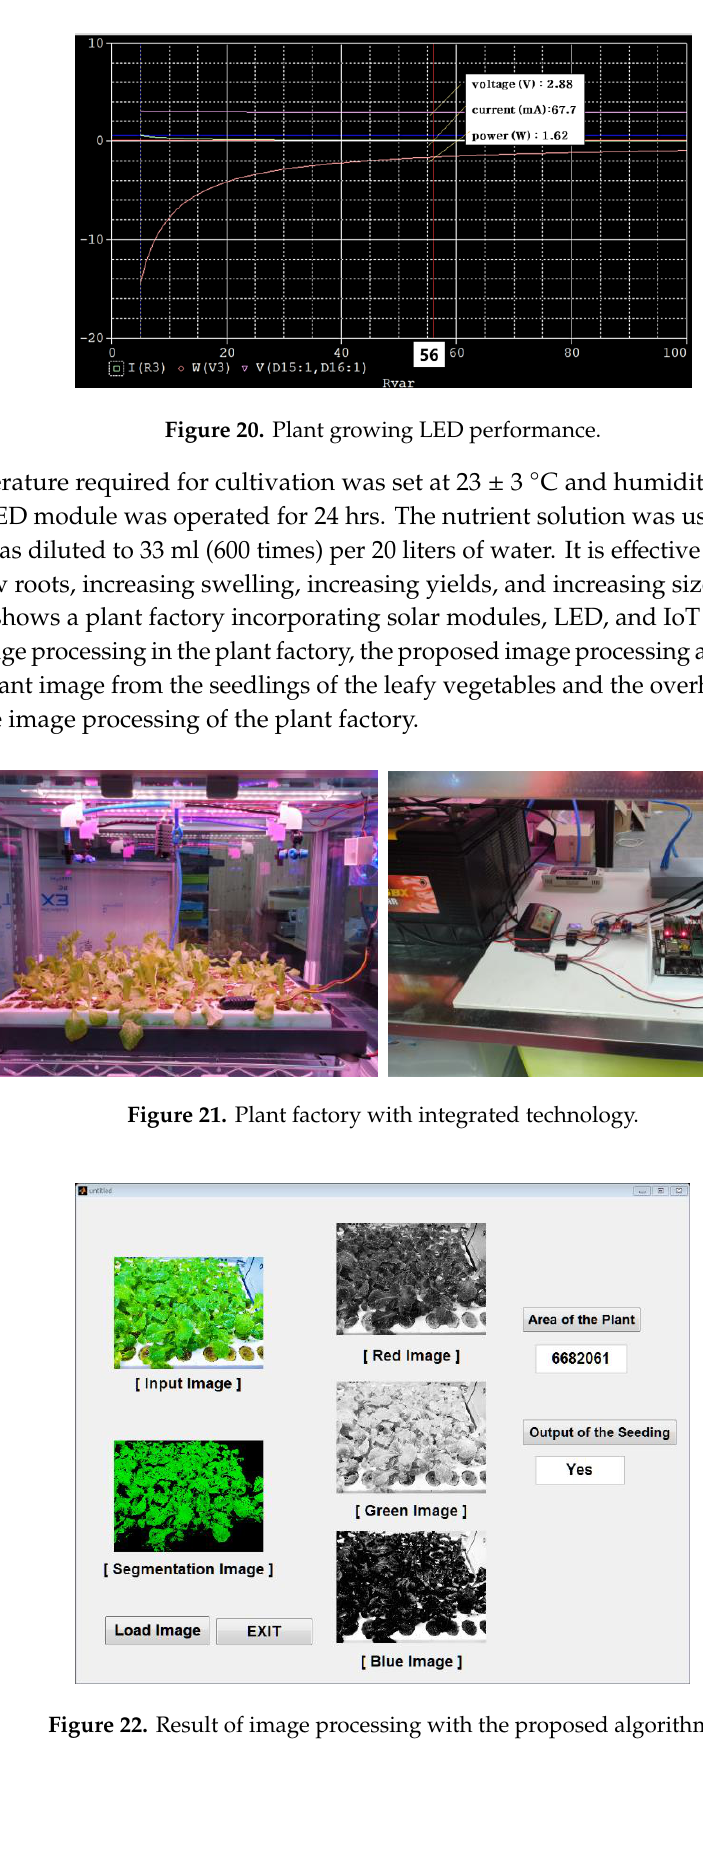
Table 4. Plant growth image processing results.